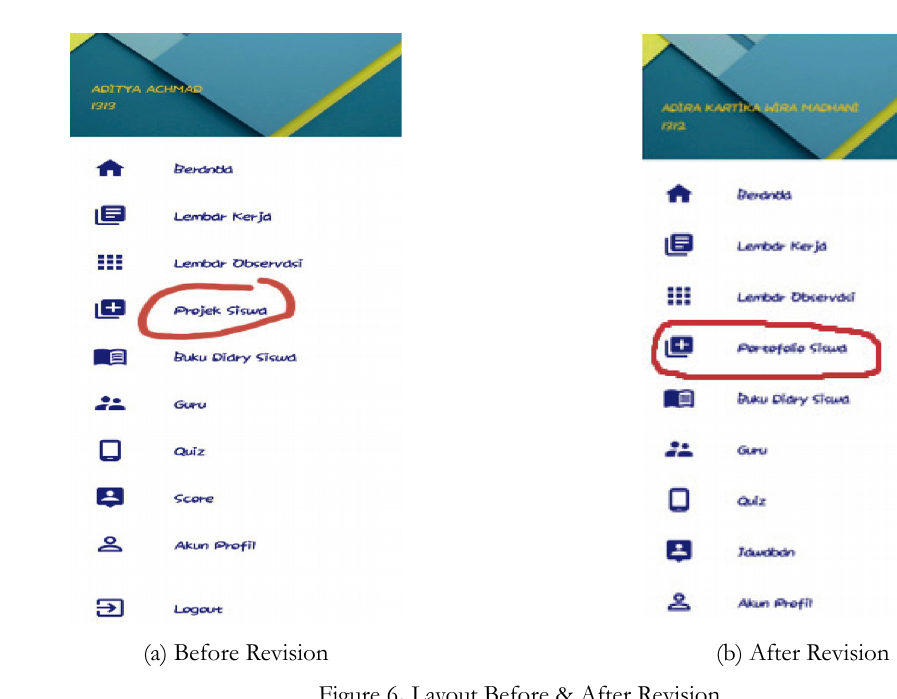
Figure 5. Layout Before & After Revision